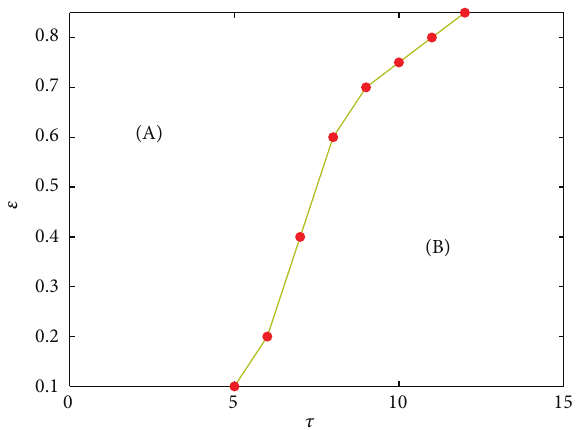
Figure 8: Phase diagram in 𝜏 − 𝜀 parameter space with 𝐴 1 = 0.35 and 𝜔 = 𝜋/6 . Regions (A) and (B) are corresponding to the 1:1 and 2:1 frequency